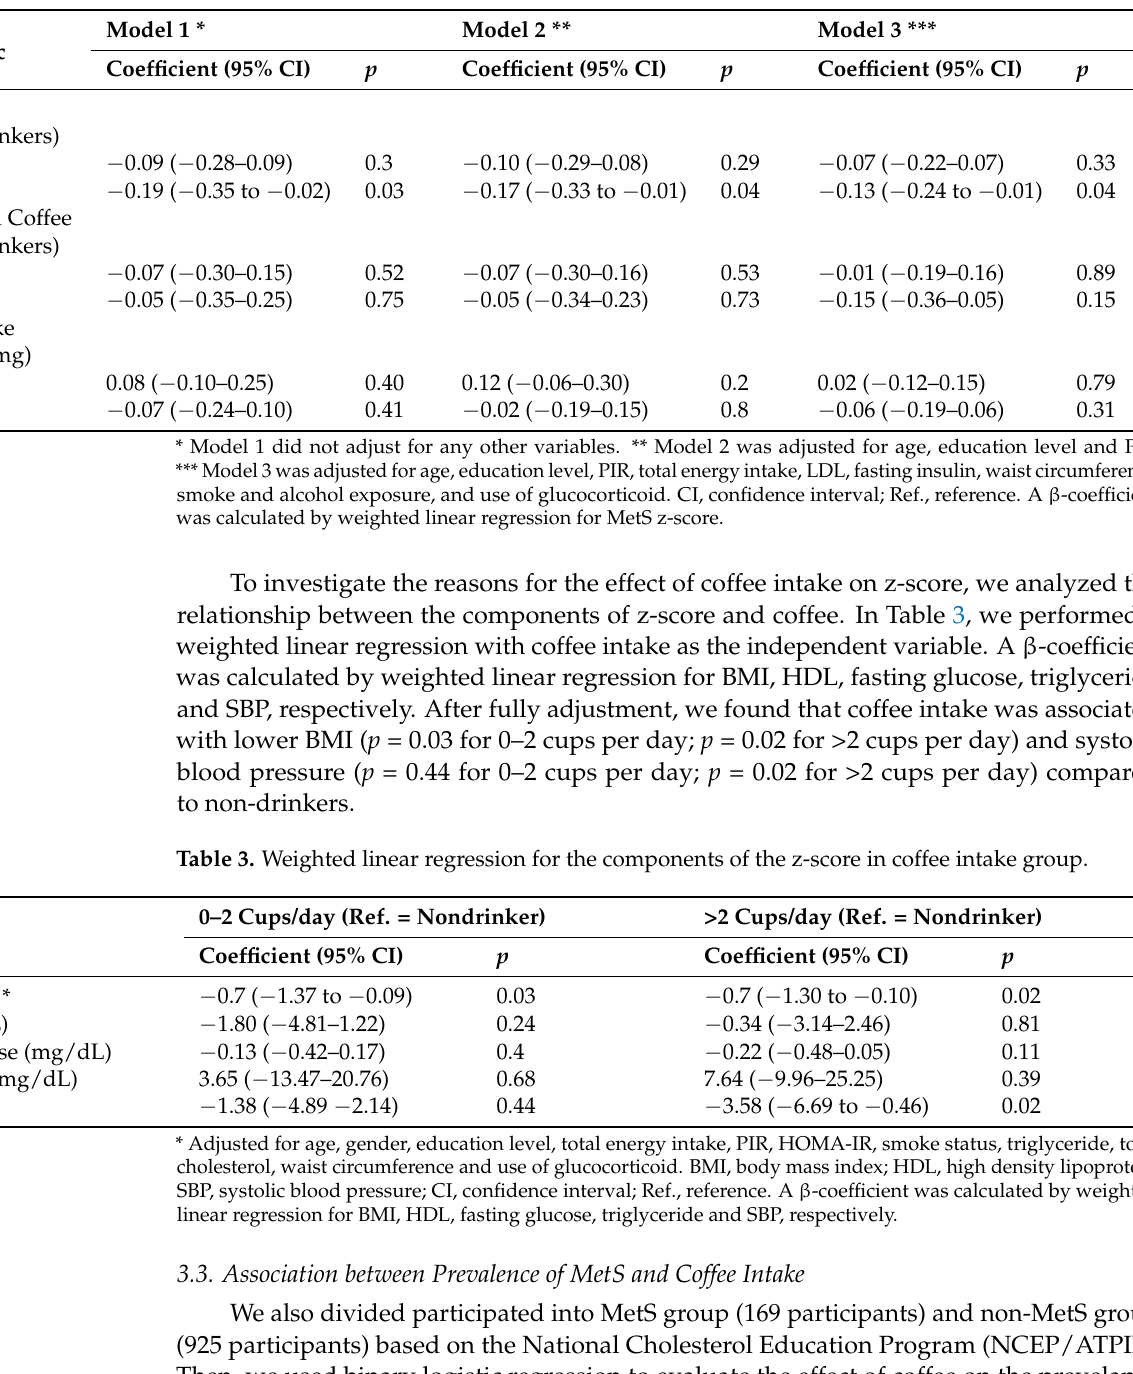
Table 2. Weighted linear regression for MetS z-score in coffee, decaffeinated coffee, and caffeine intake group.